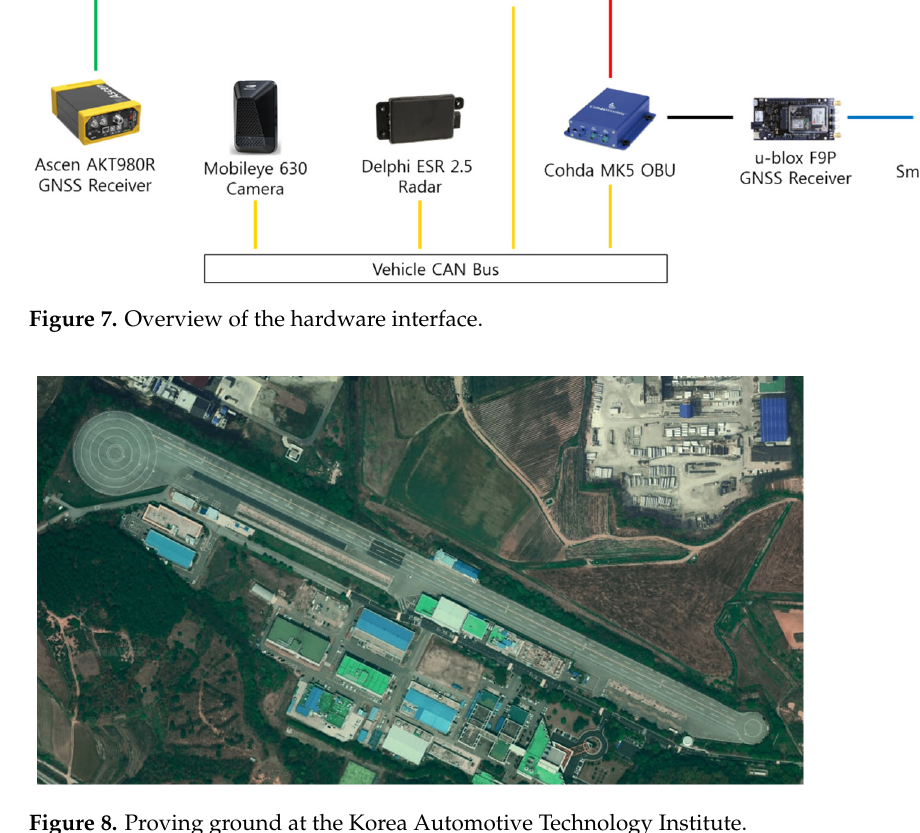
Figure 8. Proving ground at the Korea Automotive Technology Institute.